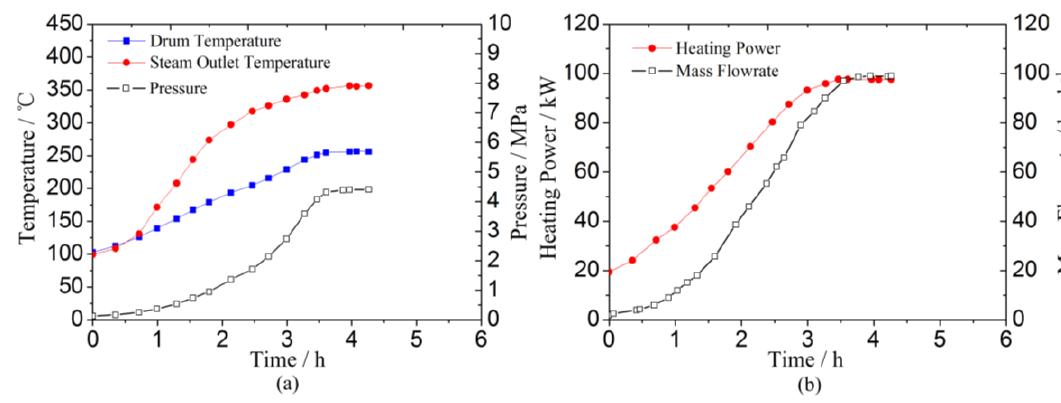
Figure 6. Start-up curves under operating pressure p = 4.2